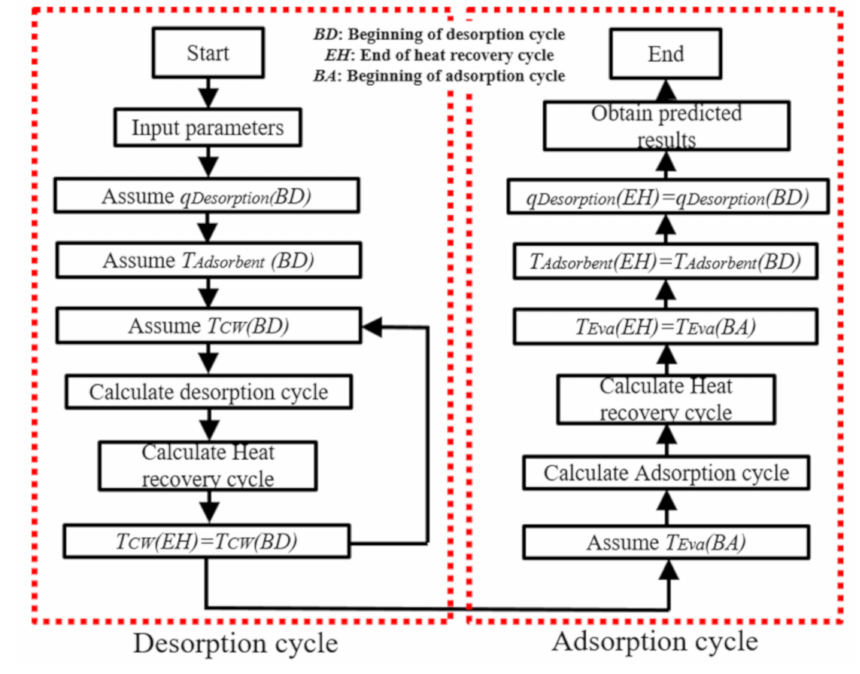
Figure 4. Solution procedure. Table 4. Control algorithm of the two-bed type AD system.